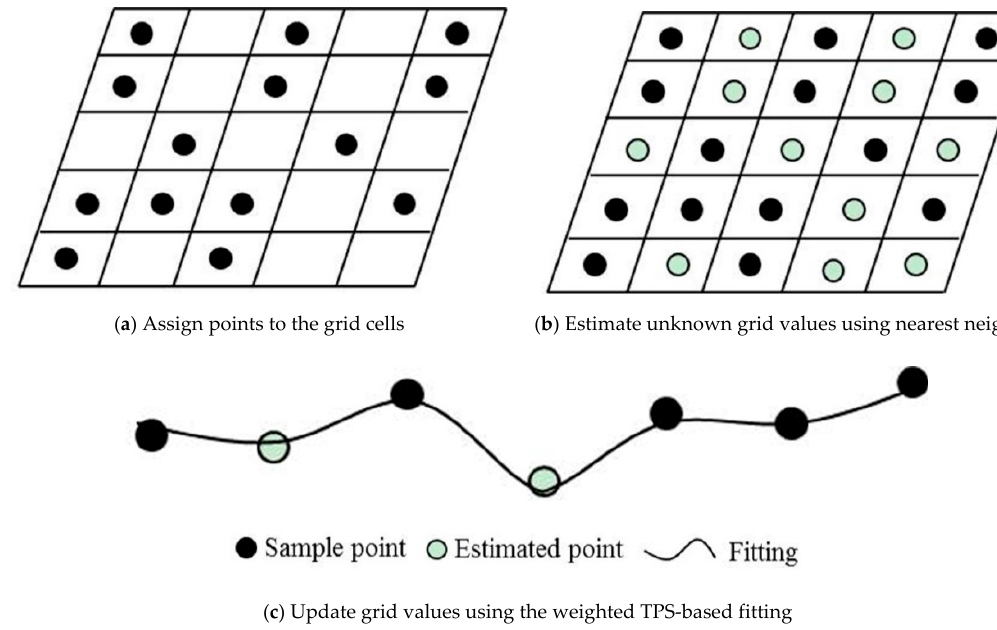
Figure 1. Schematic of the proposed method for digital terrain models (DTM) generation.